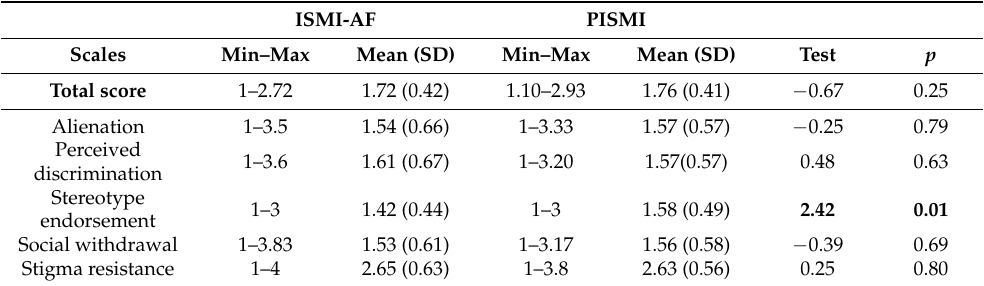
Table 2. Comparison of ISMI-AF and PISMI total scores and subscale